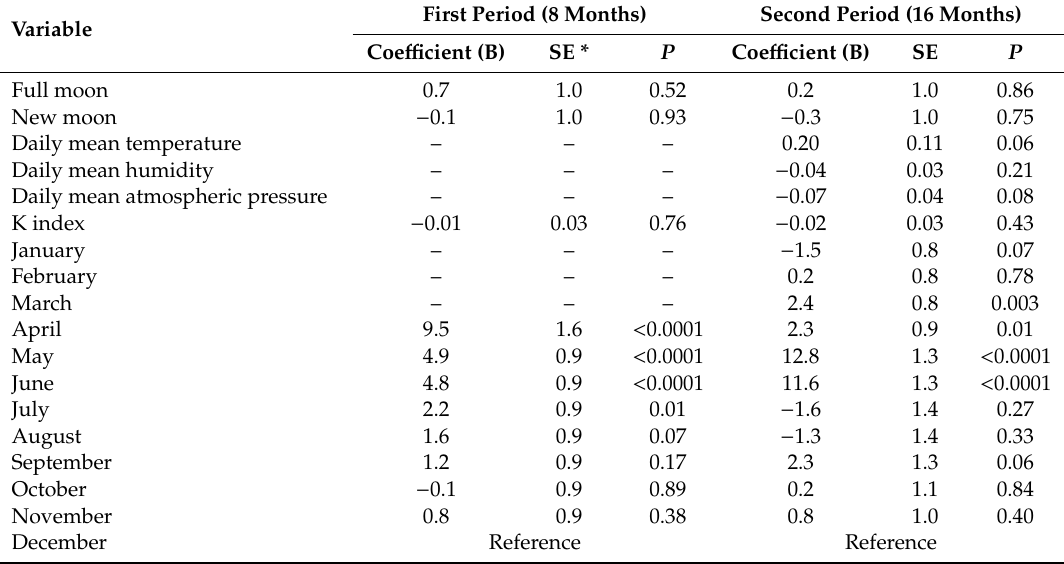
Table 2. Results of a multiple linear regression analysis investigating the number of tail lifts against the calendar month, full moon, new moon, K index, daily mean temperature, daily mean humidity, and daily mean atmospheric pressure in the control